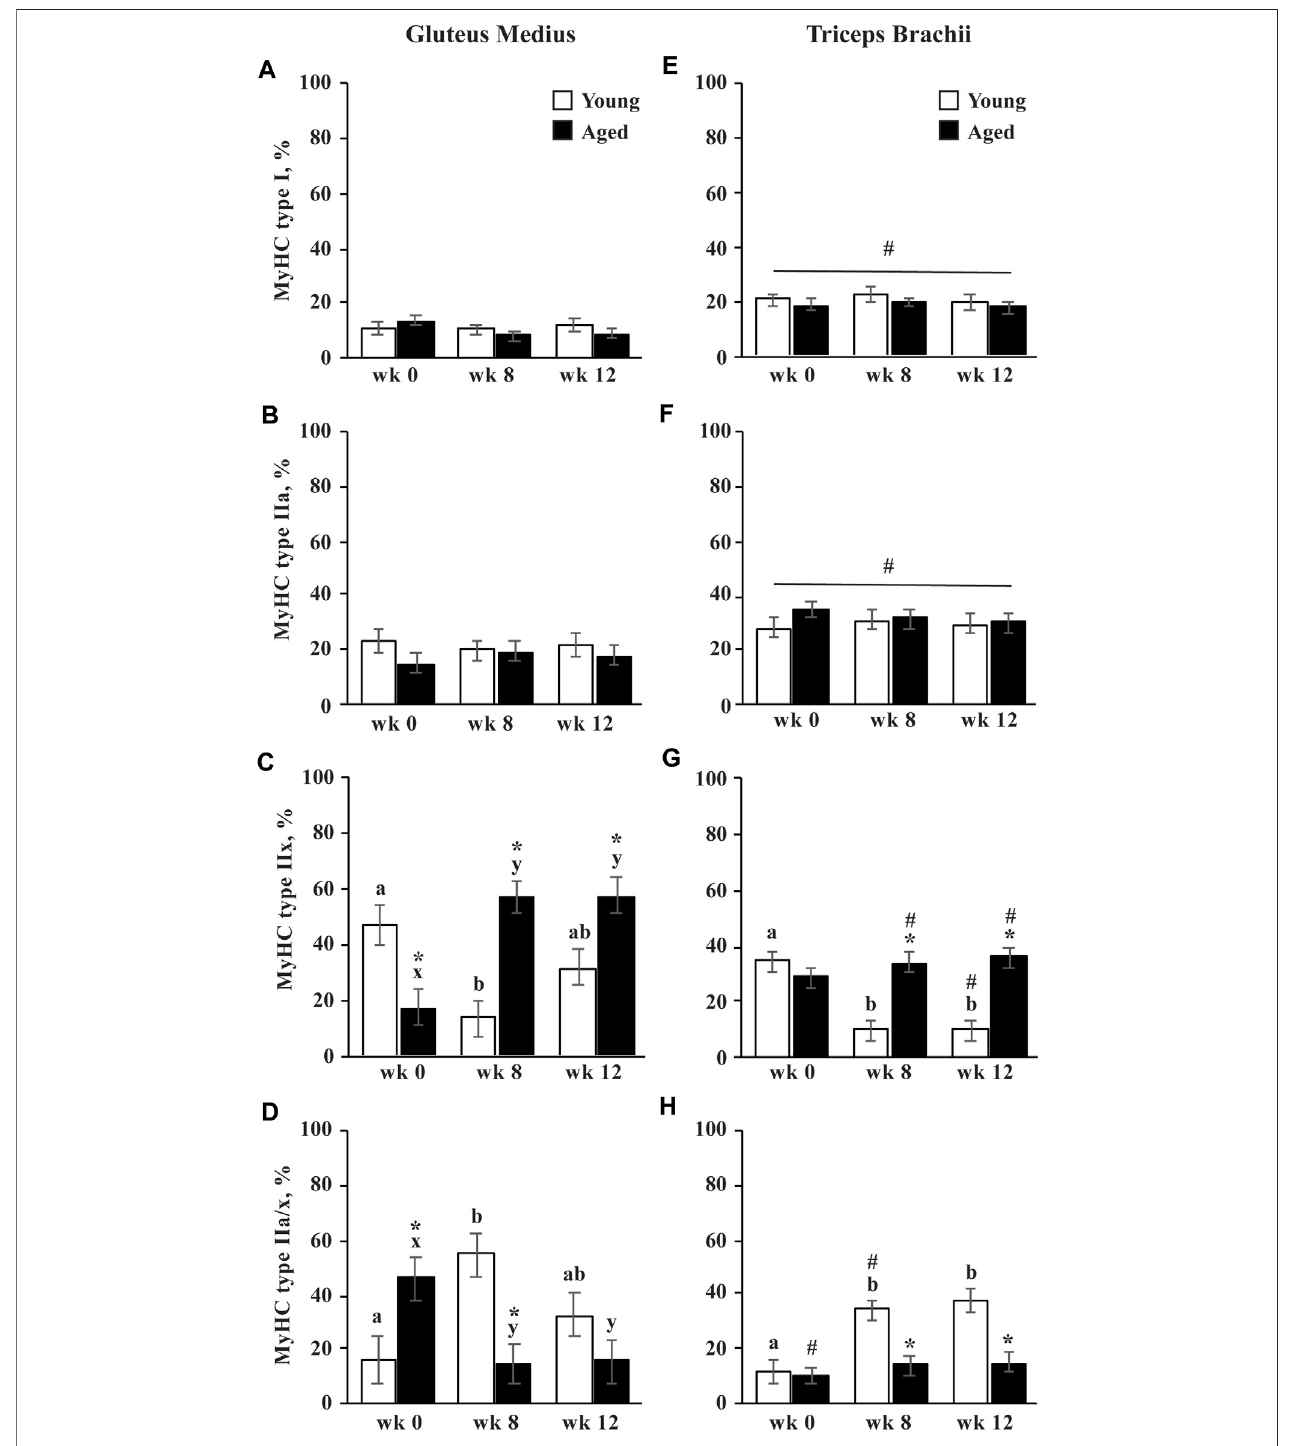
FIGURE2| Gluteusmediusand tricepsbrachiimyosin heavy chain(MyHC) typeI (A , E) ,type IIa (B , F) ,typeIIx (C , G) ,andhybrid typeIIa/x (D , H) percentage before (wk 0), and after 8 (wk 8) and 12 (wk 12) weeks of submaximal exercise training in aged (22 ± 4.5 yr; n (cid:1) 10) and young (9.7 ± 0.7 mo; n (cid:1) 8) horses. Overall effect ofage ( p (cid:1) 0.3; p (cid:1) 0.8; p (cid:1) 0.0005; p (cid:1) 0.02), training ( p (cid:1) 0.7; p (cid:1) 0.99; p (cid:1) 0.4; p (cid:1) 0.12),muscle group ( p < 0.0001; p < 0.0001; p (cid:1) 0.001; p (cid:1) 0.01),age × training ( p (cid:1) 0.5; p (cid:1) 0.9; p < 0.0001; p < 0.0001), age × musclegroup ( p (cid:1) 0.6; p (cid:1) 0.12; p (cid:1) 0.8; p (cid:1) 0.4), training × muscle group ( p (cid:1) 0.32; p (cid:1) 0.9; p (cid:1) 0.02; p (cid:1) 0.03),and age × training × musclegroup( p (cid:1) 0.5; p (cid:1) 0.3; p (cid:1) 0.02; p (cid:1) 0.01)forMyHCtypeI,typeIIa,typeIIx,andtypeIIa/x,respectively.*Withinamusclegroupandweek,ageddiffers fromyoung( p < 0.05). # Withinaweekandagegroup,GMdiffersfromTB( p < 0.05). a,b Withinyounghorsesandmusclegroup,timepointswithdifferentlettersdiffer( p < 0.05). x,y Within aged horses and muscle group, time points with different letters differ ( p < 0.05).